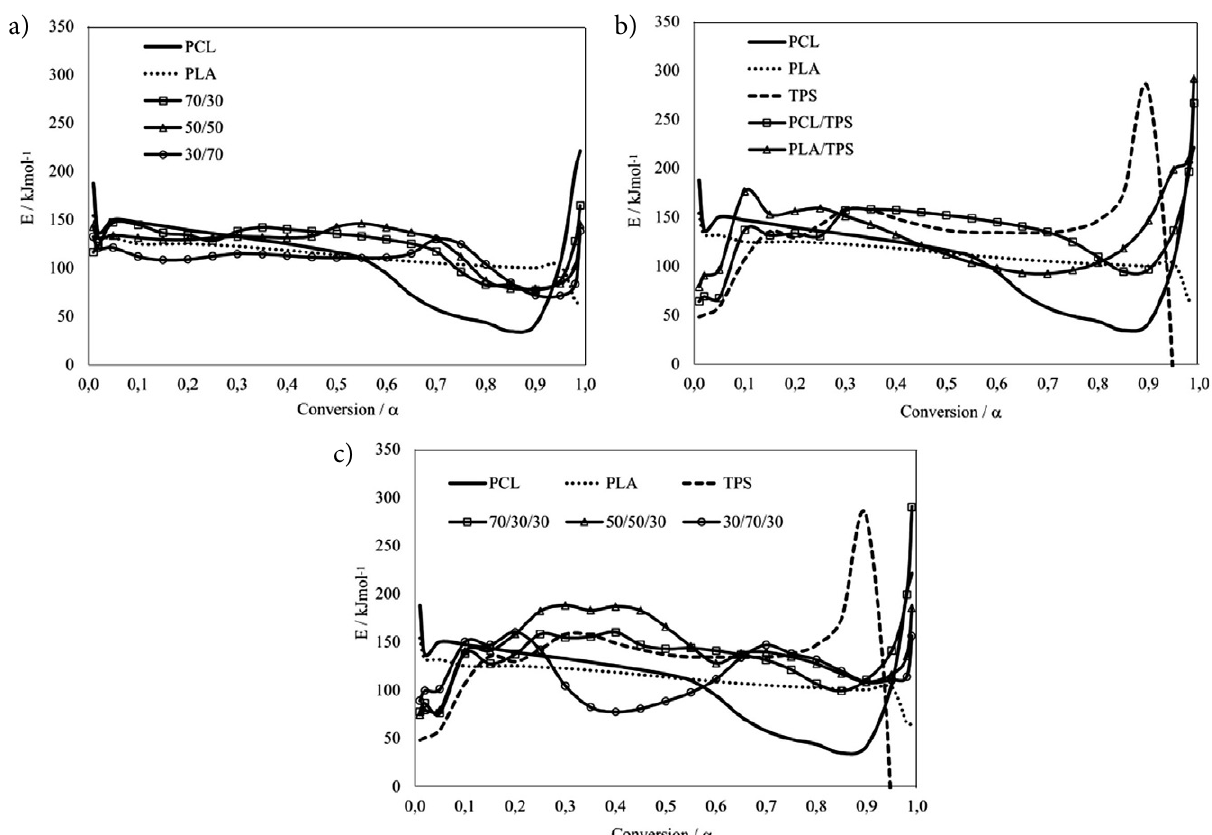
Fig. 4 . Dependence of E on α determined by Friedman method of PCL/PLA (a), PCL/TPS and PLA/TPS (b) and PCL/PLA/TPS (c)